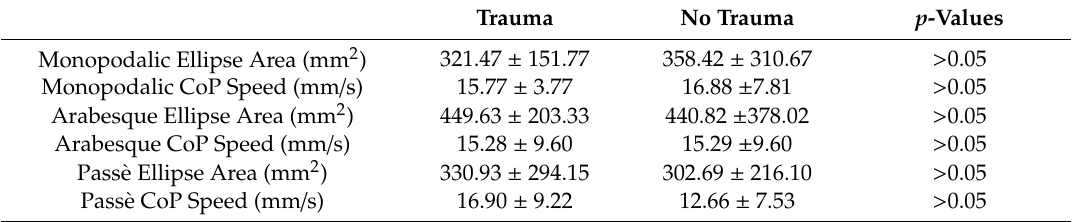
Table 4. Comparison between injured and healthy feet in pathological subjects (N = 11). Mean delta values (di ff erence between open and closed eyes) of stabilometric parameters.